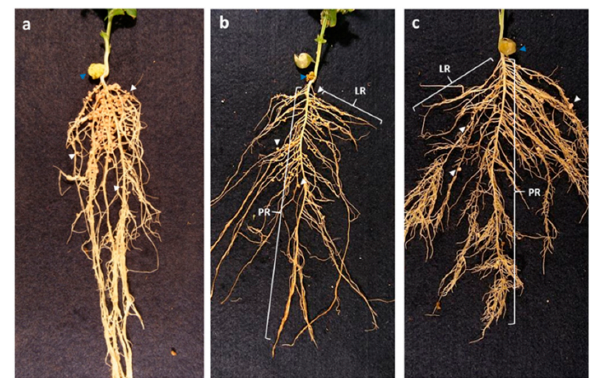
Figure 1. The root phenotypes of the di ff erent pea lines inoculated with Rhizobium leguminosarum . The images are of roots of wild-type (WT) ( a ), E107 ( b ), and E132 ( c ) harvested 42 days after inoculation. Lateral roots (LR) from the mutants have been pulled away from the primary root (PR) so that nodules (white arrowheads) could be easily distinguished. The blue arrowheads point at the shriveled cotyledons. Table 1. Quantitative characterization of the nodulated root systems of the wild-type (WT) and the mutants E107 and E132. Values are presented as means ± standard errors ( n = 6 per age, pea line, and trial; three trials were performed for a total of n =